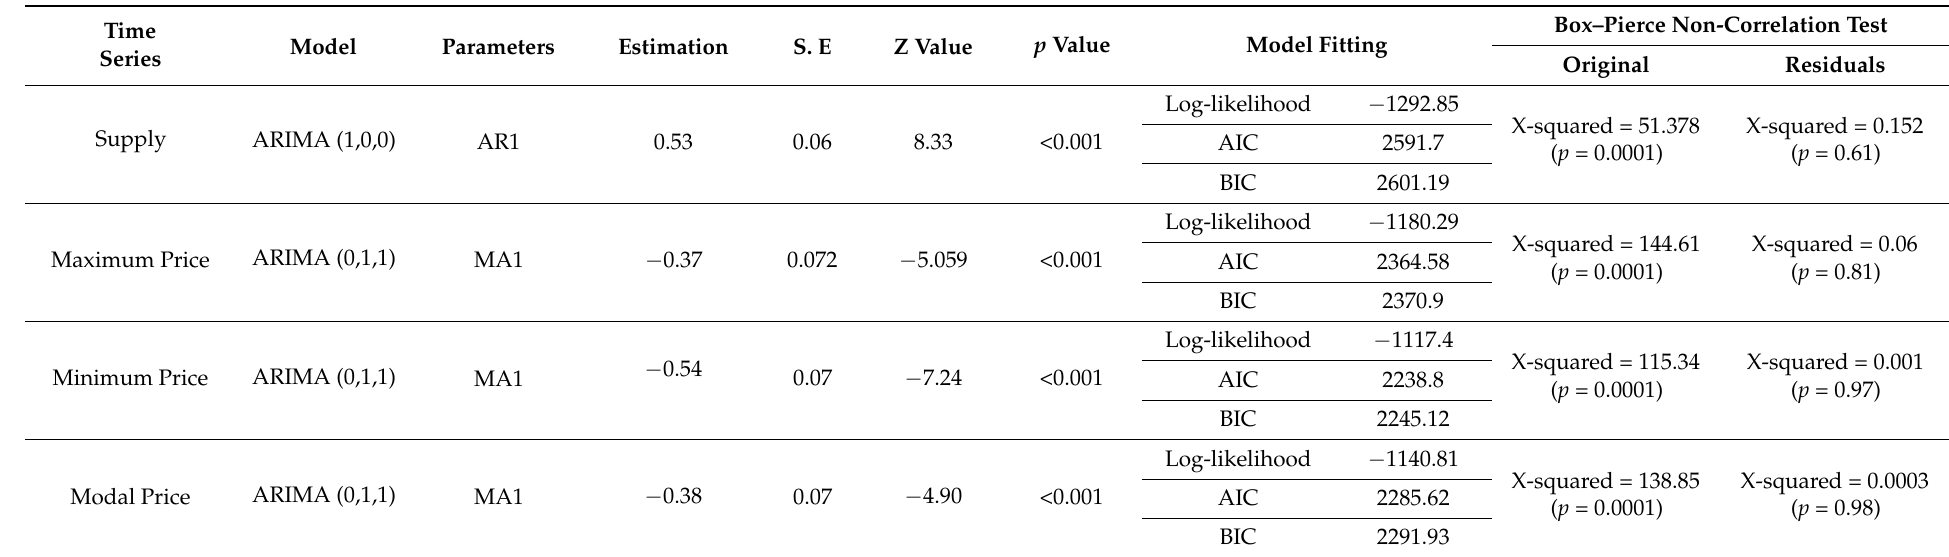
Table 3. Parameter Estimation of ARIMA